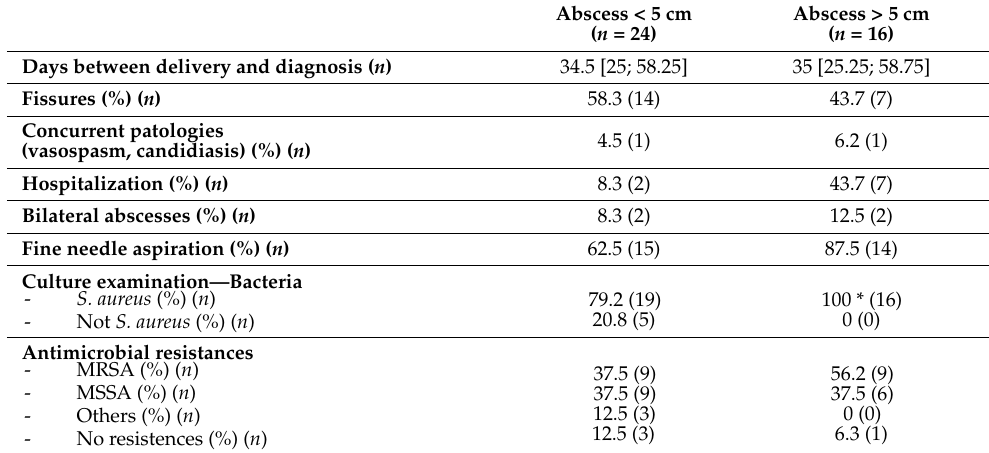
Table 3. Clinical and microbiological characteristics of patients compared by the size of